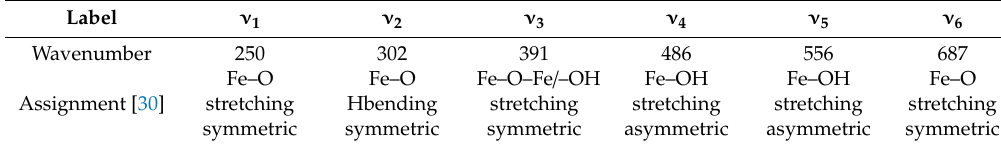
Table 1. Assignments of the observed Raman peak of goethite at ambient conditions.